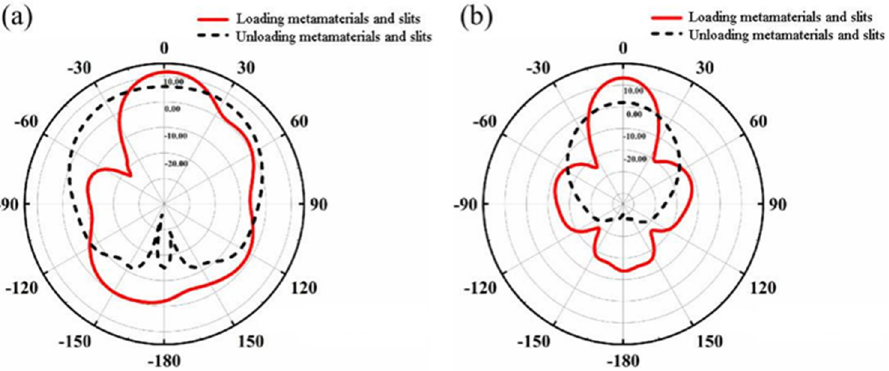
Figure 14. Radiation patterns of a nested double-hexagon ring-shaped metamaterial slot antenna and a reference antenna ( a ) E -plane ( b ) H -plane.